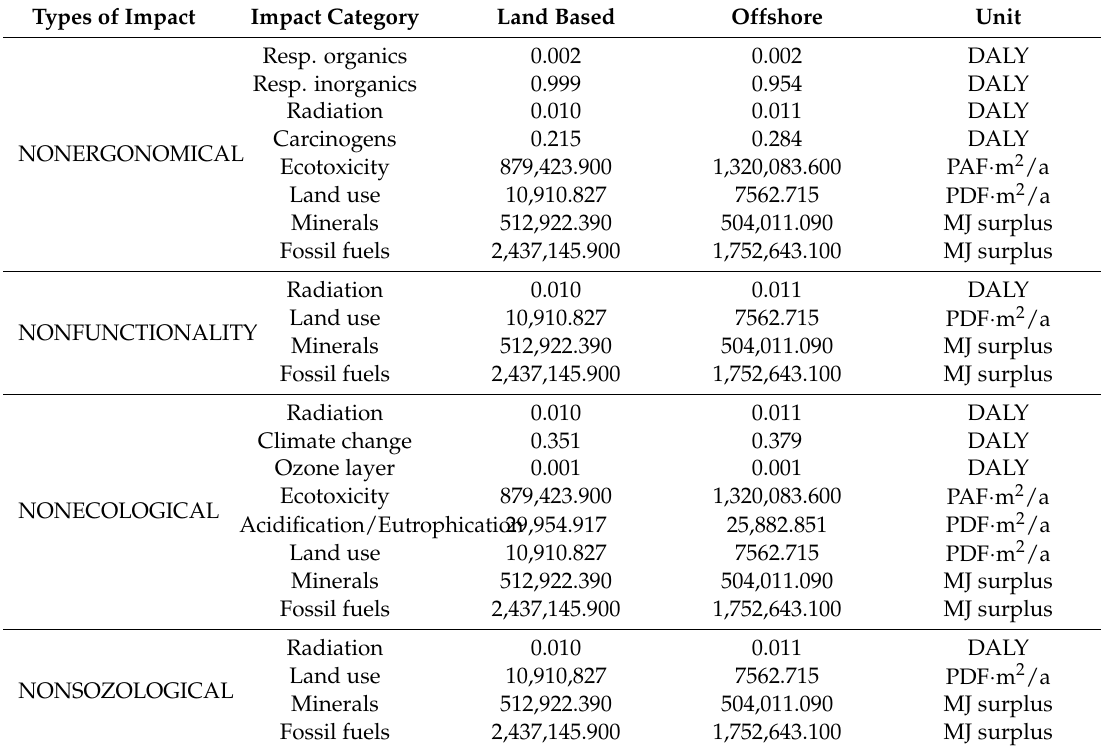
Table 1. Results of characterization of the environmental effects that occur in life cycles of land-based and offshore wind farms. Authors’ own